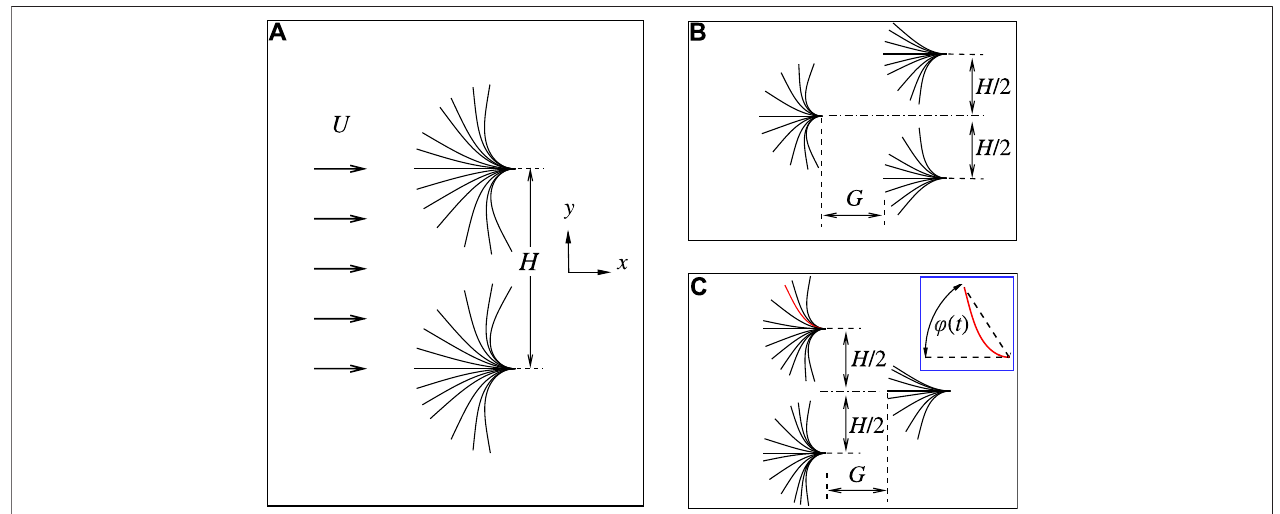
FIGURE 1 | Schematic diagram for fl uid fl ows past fl exible inverted fl ags in side-by-side (A) , left triangular (B) and right triangular (C) con fi gurations. The plates are immersed in a uniform in fl ow with speed U in the x -direction. The trailing edges of the fl ags are fi xed, and the remainders are free to move due to the fl ow-structure interaction. H is the vertical distance between the parallel inverted fl ags, and G is the horizontal distance from the trailing edge of the front fl ag to the leading edge of the rear fl ag at the initial positions. φ ( t ) is the instantaneous fl apping angle that can be de fi ned as the angle between the x -axis and the secant connecting the leading- edge to the